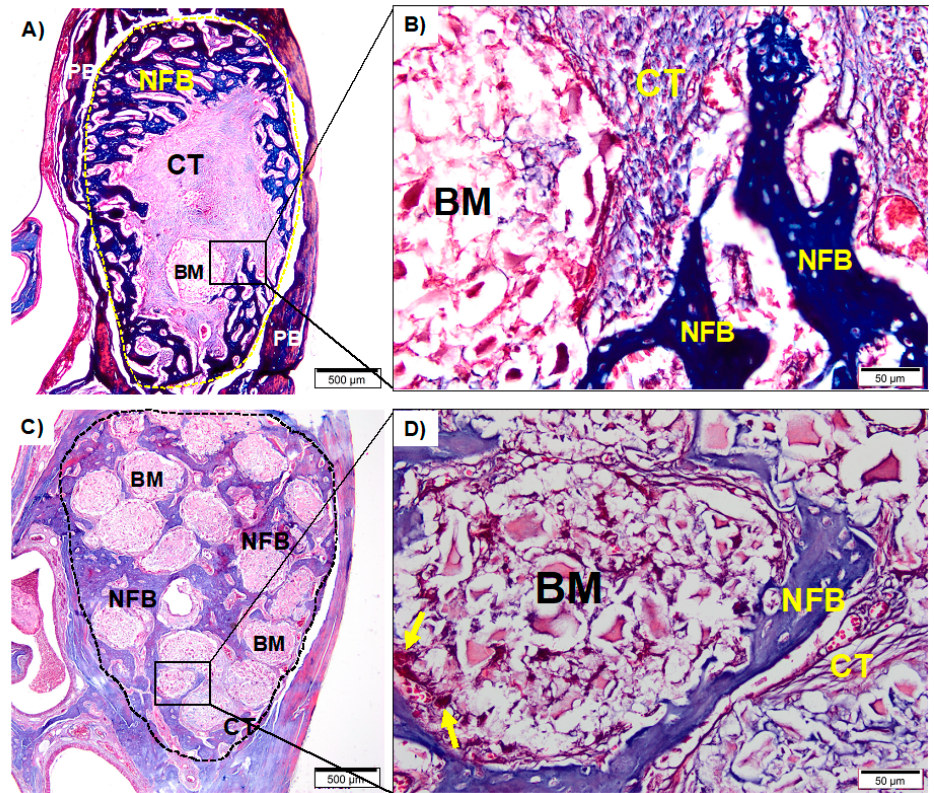
Figure 6. ( A ): Photomicrograph of HA 8% ZA group after 28 days at 20× magnification. ( B ): HA 8% ZA group in detail at 40× magnification. ( C ): Photomicrograph of HADOX 8% ZA group after 28 days at 20× magnification. ( D ): HADOX 8% ZA in detail at 40× magnification. Newly formed bone (NFB); connective tissue (CT) pre-existing bone (PB); biomaterial (BM); multinucleated giant cells (yellow arrows). ( A , C ): scale bar 500 μ m; ( B , D ): scale bar: 50 μ m. The interest area is circulated by the dotted staining with Masson’s Trichrome.